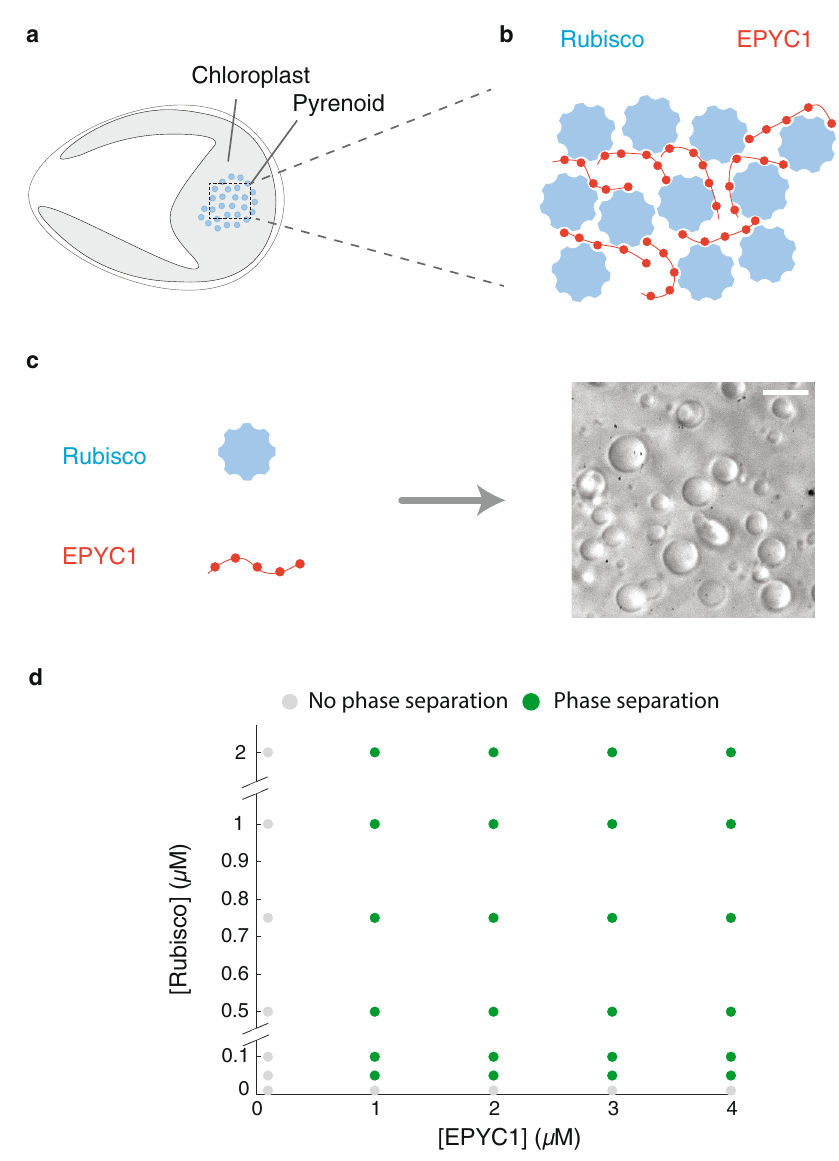
Fig. 1 The components of the pyrenoid — EPYC1 and Rubisco — phase separate in vitro over a broad range of protein concentrations. a Sketch of a Chlamydomonas reinhardtii cell, highlighting the chloroplast and the pyrenoid. The blue circles indicate Rubisco holoenzymes in the pyrenoid matrix. b Cartoon illustrating that the pyrenoid matrix is held together by multivalent interactions between EPYC1 and Rubisco. c Puri fi ed EPYC1 and Rubisco, when mixed together, phase separate in vitro. Scale bar, 5 μ m. d Phase diagram of Rubisco-EPYC1 phase separation. Concentrations are expressed in terms of Rubisco holoenzymes and EPYC1